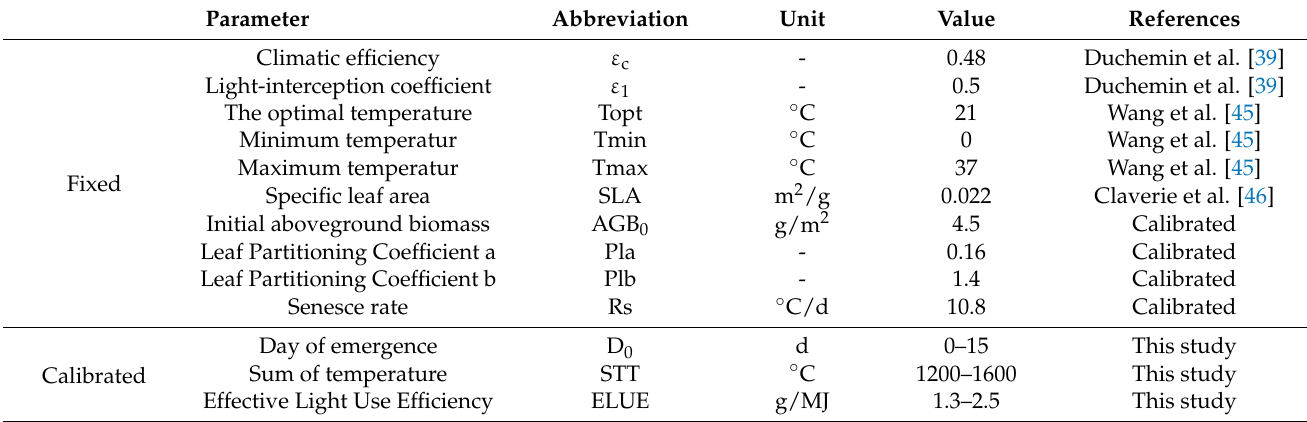
Table 2. Parameter descriptions in the SAFY